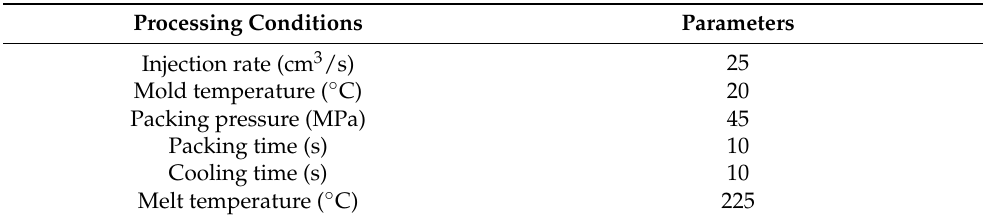
Table 3. Processing parameters in of the cavity pressure experiment.